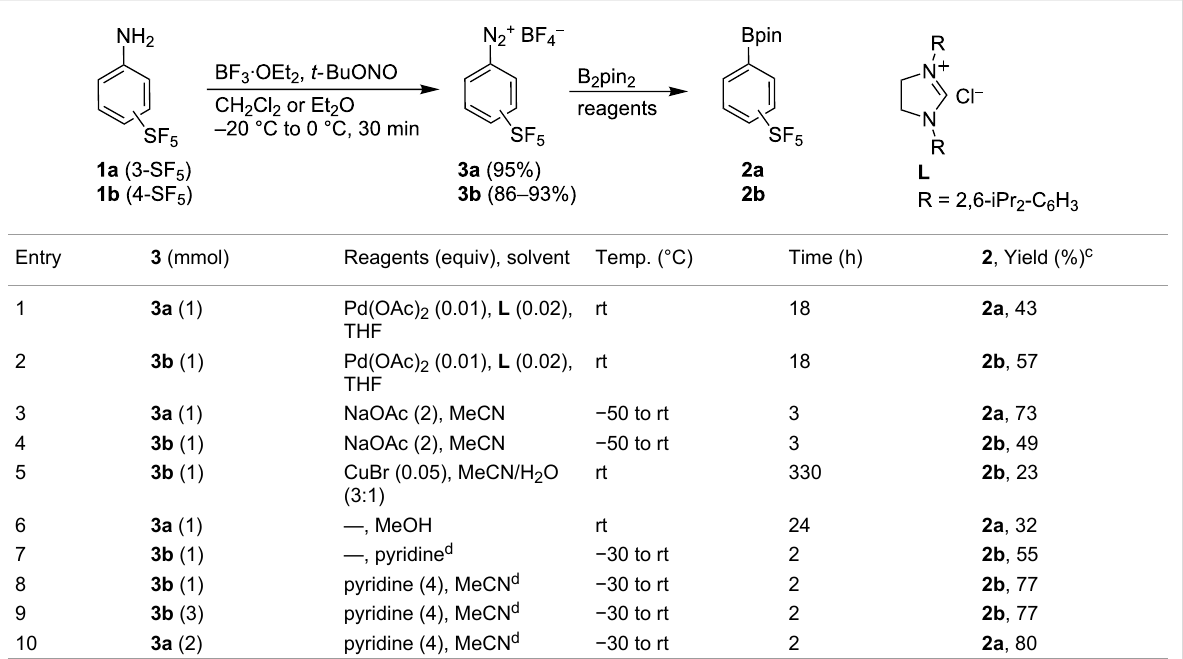
Table 2: Synthesis of diazonium tetrafluoroborates 3 a and boronates 2 b .